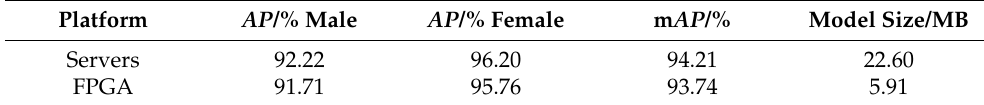
Table 6. Comparison of test results of different test